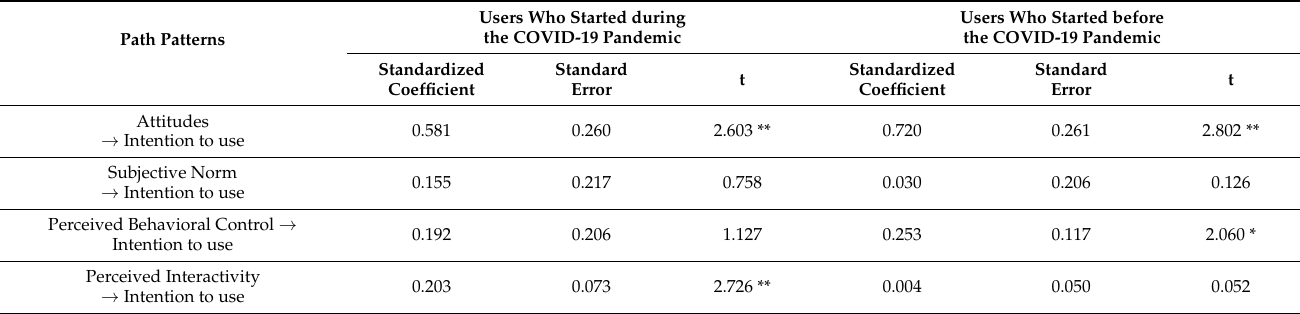
Table 6. Multigroup path analysis results.